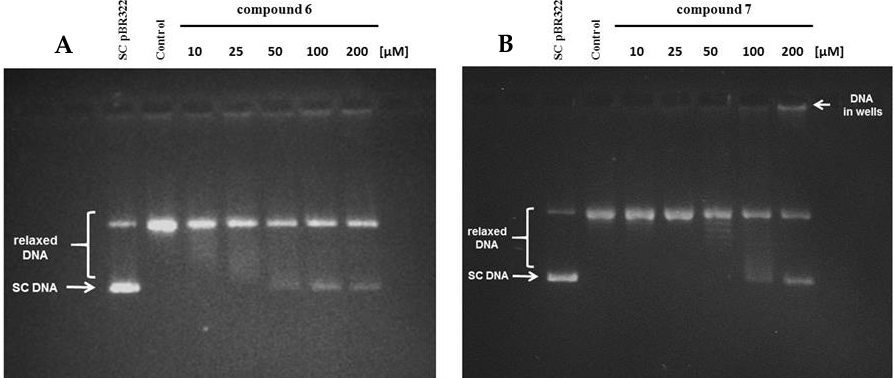
Figure 8. Inhibition of the relaxation activity of human topoisomerase II α in the presence of compounds 6 ( A ) and 7 ( B ) at concentrations of 10, 25, 50, 100, and 200 µM. SC—supercoiled DNA.